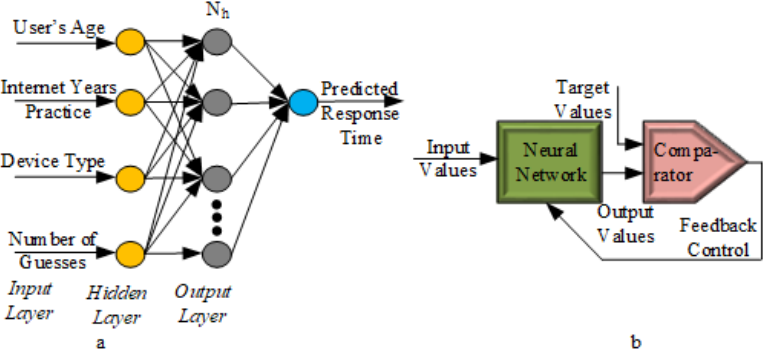
Figure 4. ( a ) ANN proposed structure; and ( b ) ANN learning